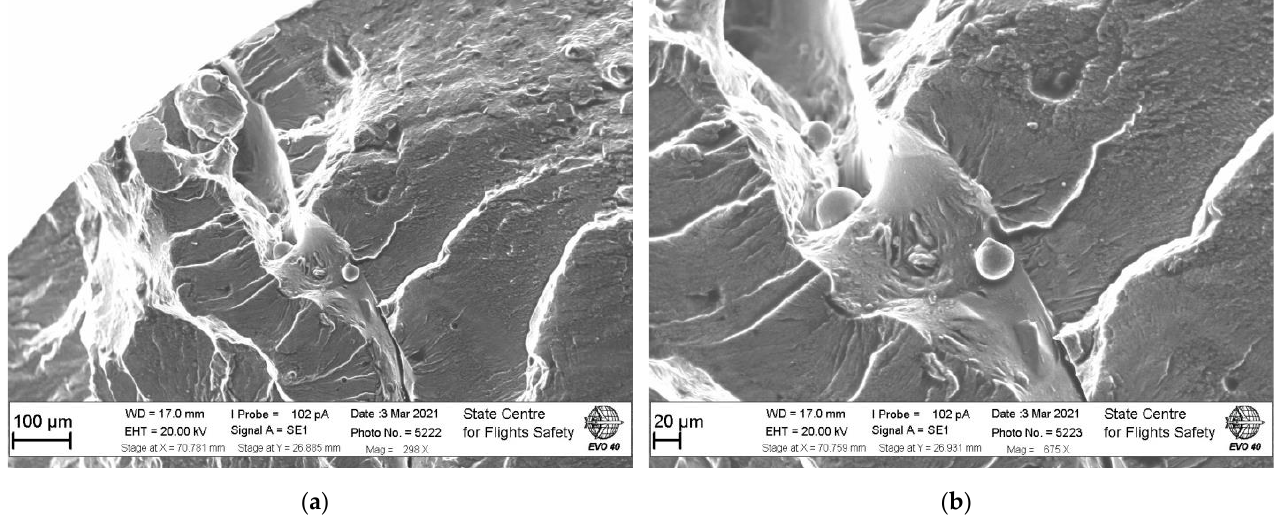
Figure 14. The details of crack growth in SLM specimens under VHCF loading. General image ( a ), detailed image ( b ).